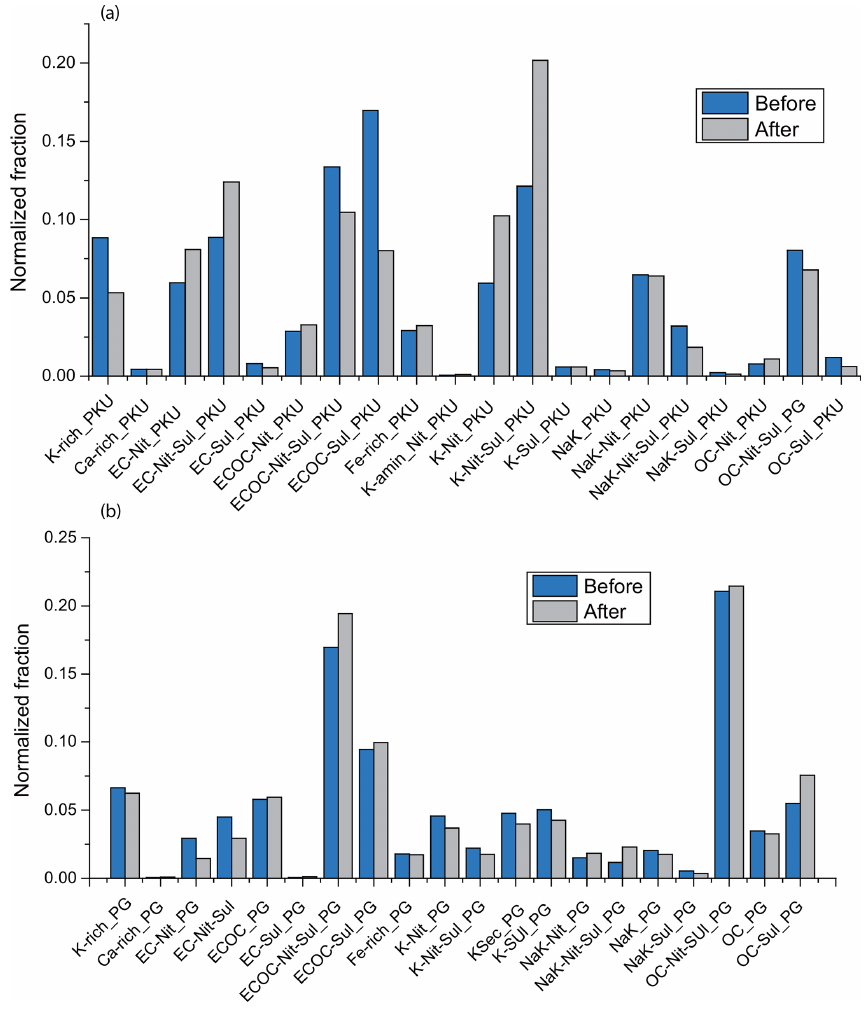
Figure 5. Variation of particle number fractions at PKU and PG before and after the heating period 2016–2017.